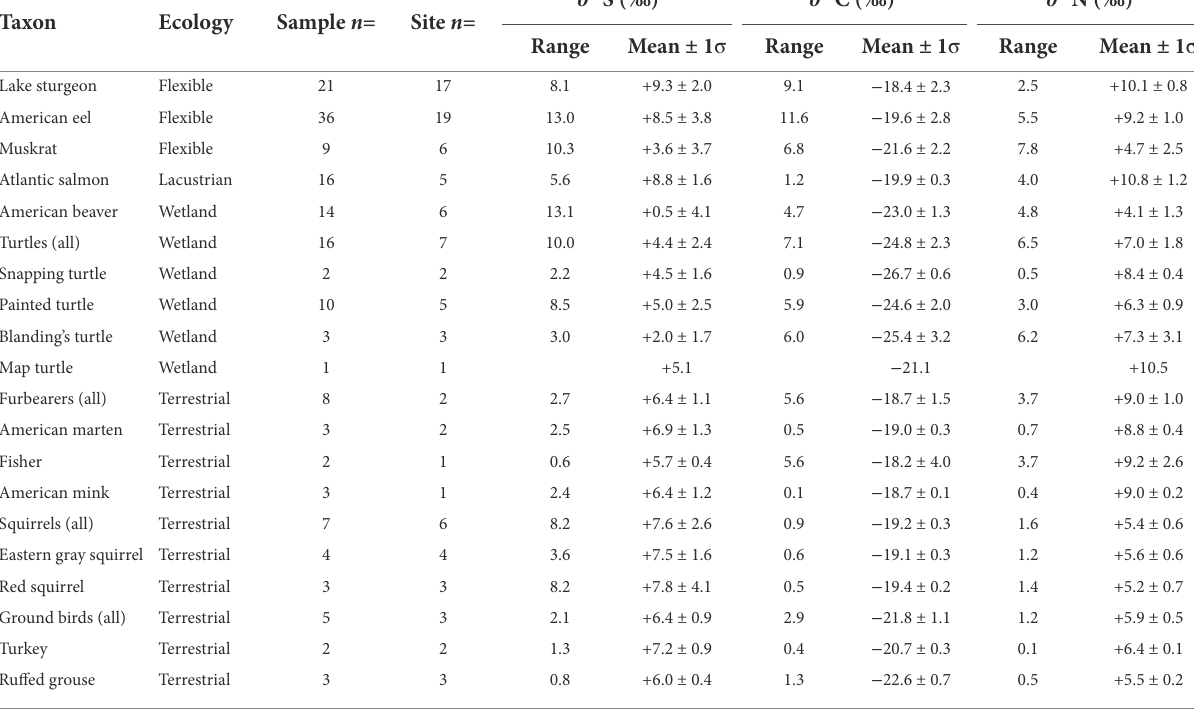
TABLE 1 Summary statistics for archaeological faunal bone collagen isotopic compositions.